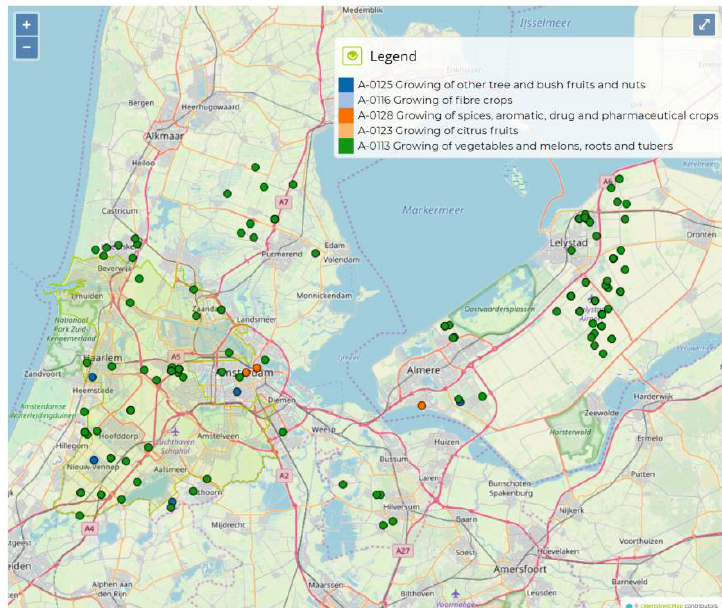
Figure 11. Workshop participants used the GDSE to visualize locations of potential actors involved in growing vegetables and fruits in the focus area that can be involved in the EIS based on the selection of activities made by the participants.